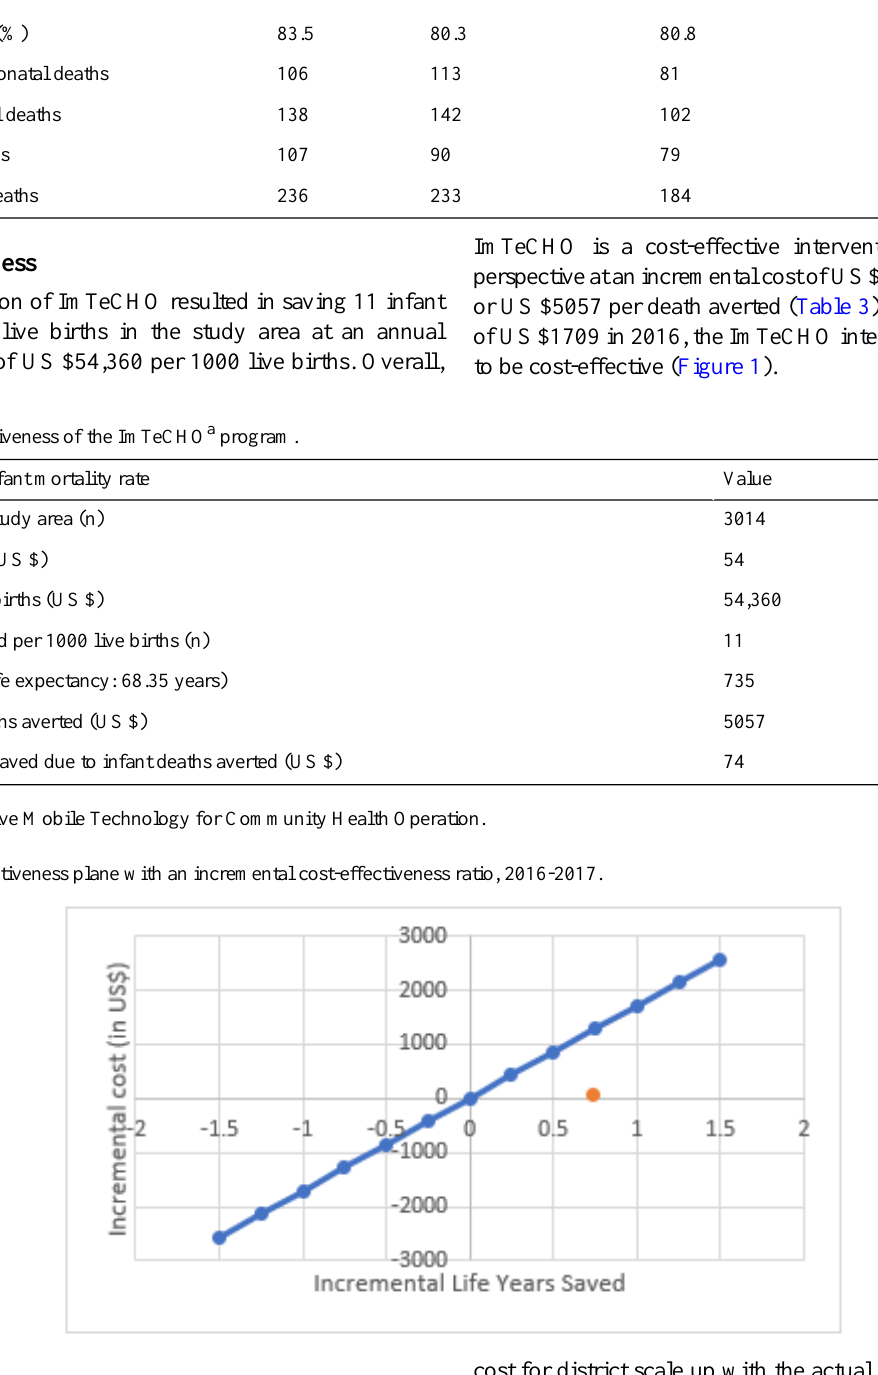
Per ProtocolIntention to TreatVariable